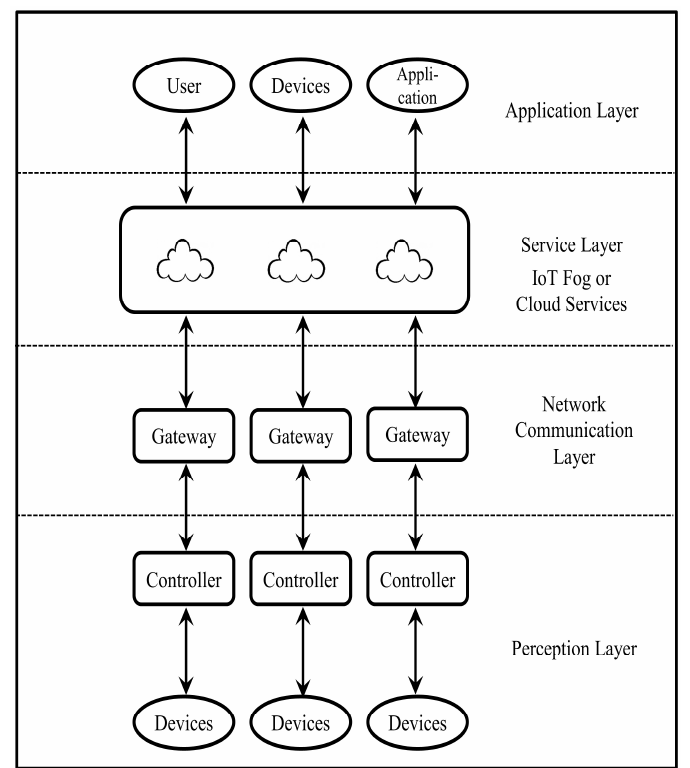
Figure 2. IoT Hierarchical Architecture.